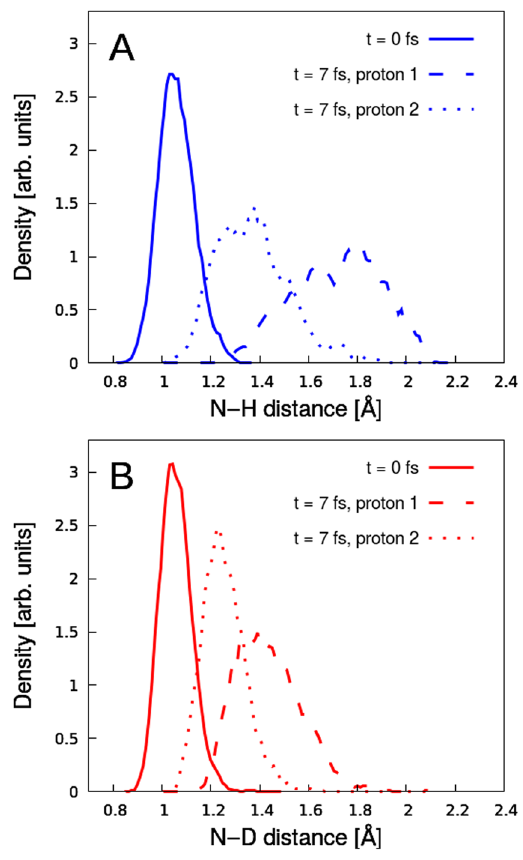
Figure 3. Time-dependent proton (deuteron) densities along the proton (deuteron) -transfer coordinates obtained from MD simulations on the core-ionized state of the ( A ) + NH (H O) The initial structures were taken from liquid-phase MD simulations of the solvated ammonium cation in the ground state. Densities along the strongest (dashed line) and second strongest (dotted line) N–H bonds are shown after 7 fs, together with the ground-state proton density (thick